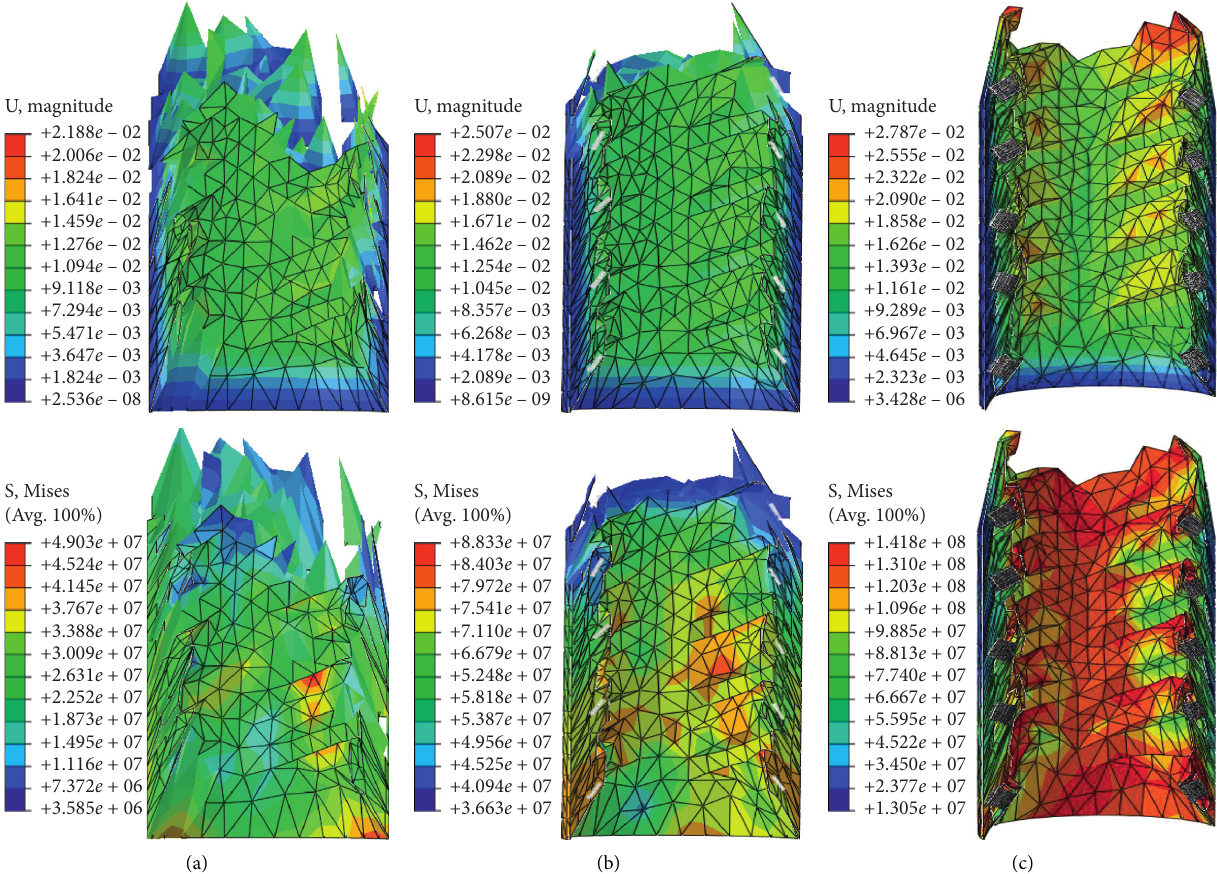
Figure 9: The stress and corresponding displacement of three types of resin grout at the postpeak stage: (a) pure resin grout, (b) resin grout with 0.6mm diameter steel segment, and (c) resin grout with 3mm diameter steel